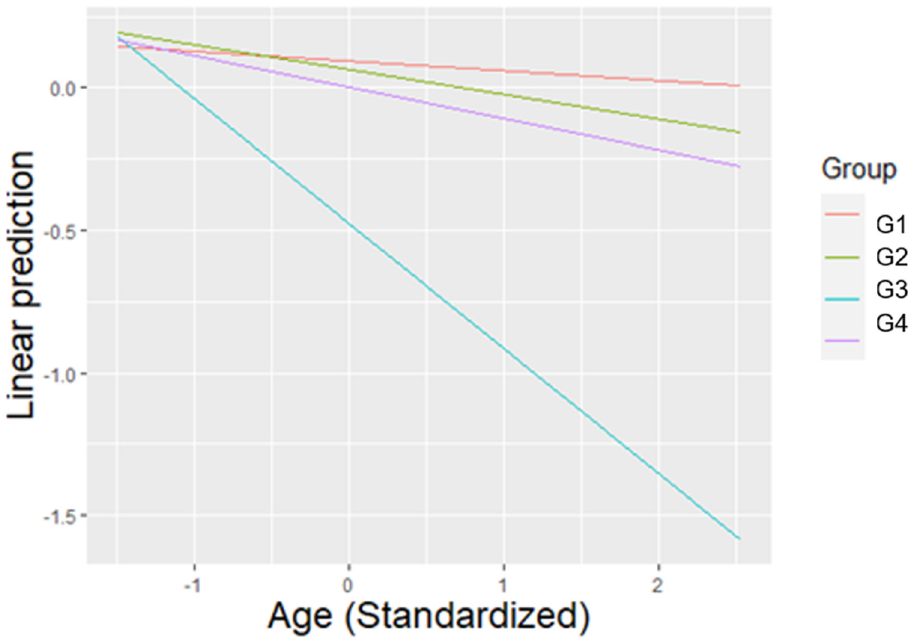
Figure 1. The linear prediction of the relative frequency of affiliative behaviours according to the average value of age (previously standardized), for each group. For the average value of age, Group 3 displayed significantly less affiliative behaviours than all other groups.